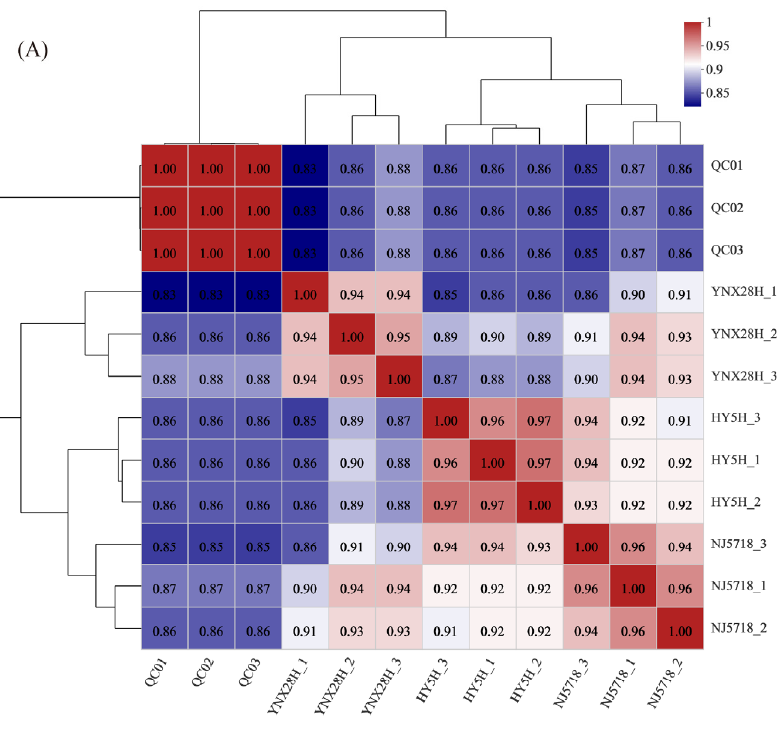
Figure 2. Sample reproducibility and metabolite analysis. ( A ) Correlation heatmap of three semi- glutinous japonica rice grain samples. The right and inferior sides in the figure are the sample names. ( B ) Pairwise comparison of DMs. ( C ) Venn distribution of metabolites. HY5H, Hongyang 5 hao; YNX28H, Yangnongxiang 28; NJ5718, Nanjing 5718. 3.3. Metabolic Profiling A total of 188 DMs were identified between HY5H and NJ5718 (152 upregulated and 36 downregulated) (Figure 2B; Table S2). Glycerophospholipids accounted for 9.45% of the detected DMs. Prenol lipids formed 6.30% of the total DMs. Flavonoids comprised 2.36% of the total DMs. Glycerolipids accounted for 2.36%, phenols represented 0.79%, and coumarins and their derivatives accounted for 0.79% of the DMs (Figure 3A). A total of 136 DMs were identified between YNX28H and NJ5718 (99 upregulated and 37 down- regulated) (Figure 2B; Table S3). Prenol lipids accounted for 17.05% of the detected DMs. Glycerophospholipids accounted for 6.82%, glycerolipids accounted for 4.55%, lignan gly- cosides accounted for 1.14%, phenols accounted for 1.14%, and flavonoids accounted for 1.14% of DMs (Figure 3B). A total of 198 DMs were identified between HY5H and YNX28H (102 upregulated and 96 downregulated) (Figure 2B; Table S4). Prenol lipids ac- counted for 10.32% of the detected DMs. Glycerophospholipids represented 6.35%, glyc- erolipids accounted for 3.97%, cinnamic acids and their derivatives accounted for 3.17%,